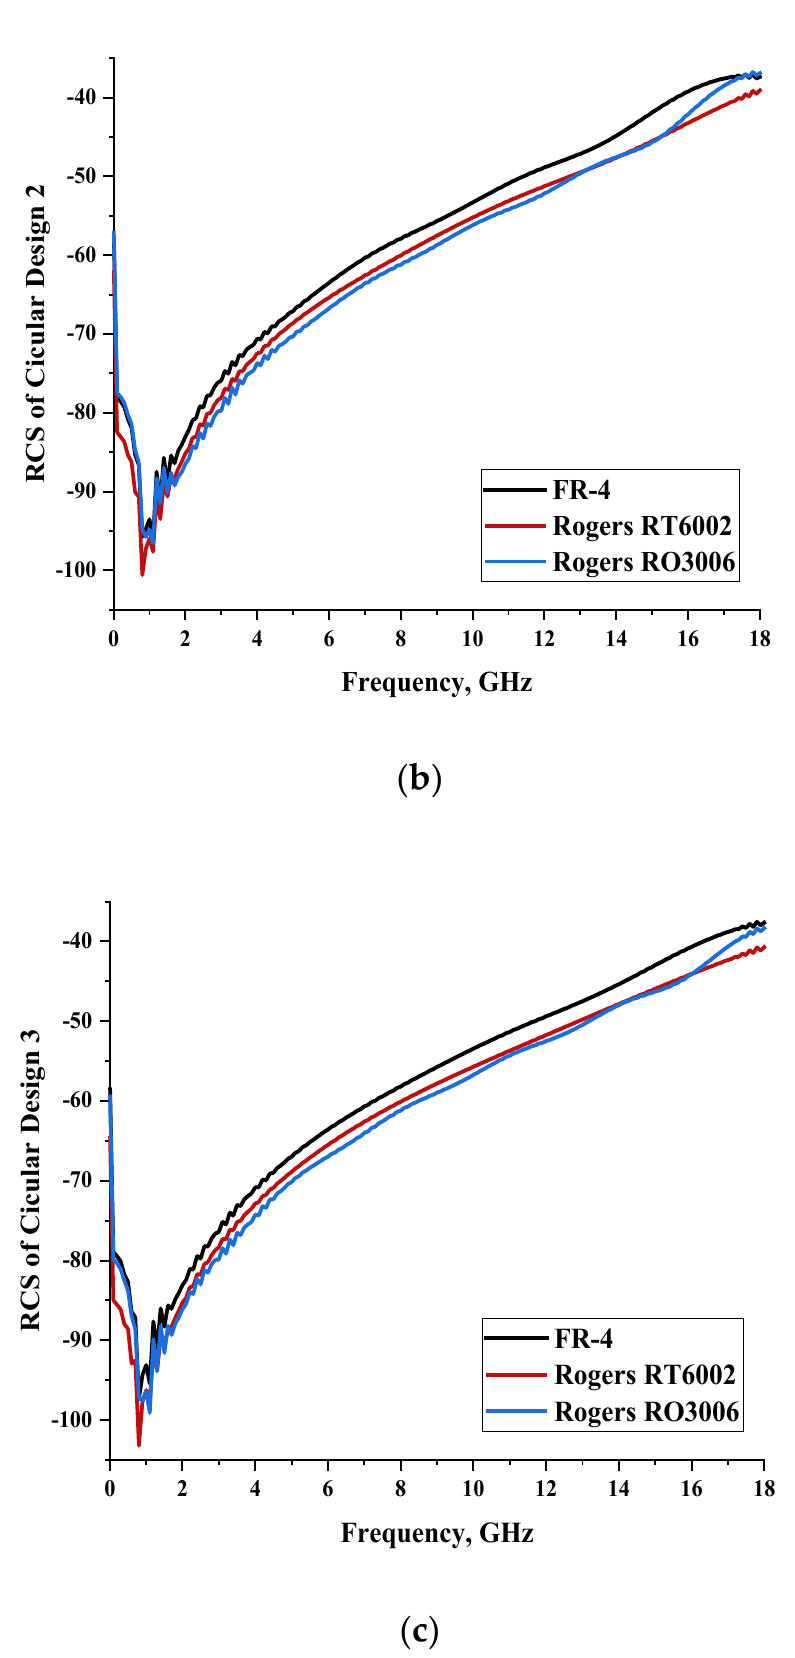
Figure 1. Monostatic RCS values for circular metamaterial unit-cell design with various substrate materials: ( a ) Design 1; ( b ) Design 2; and ( c ) Design